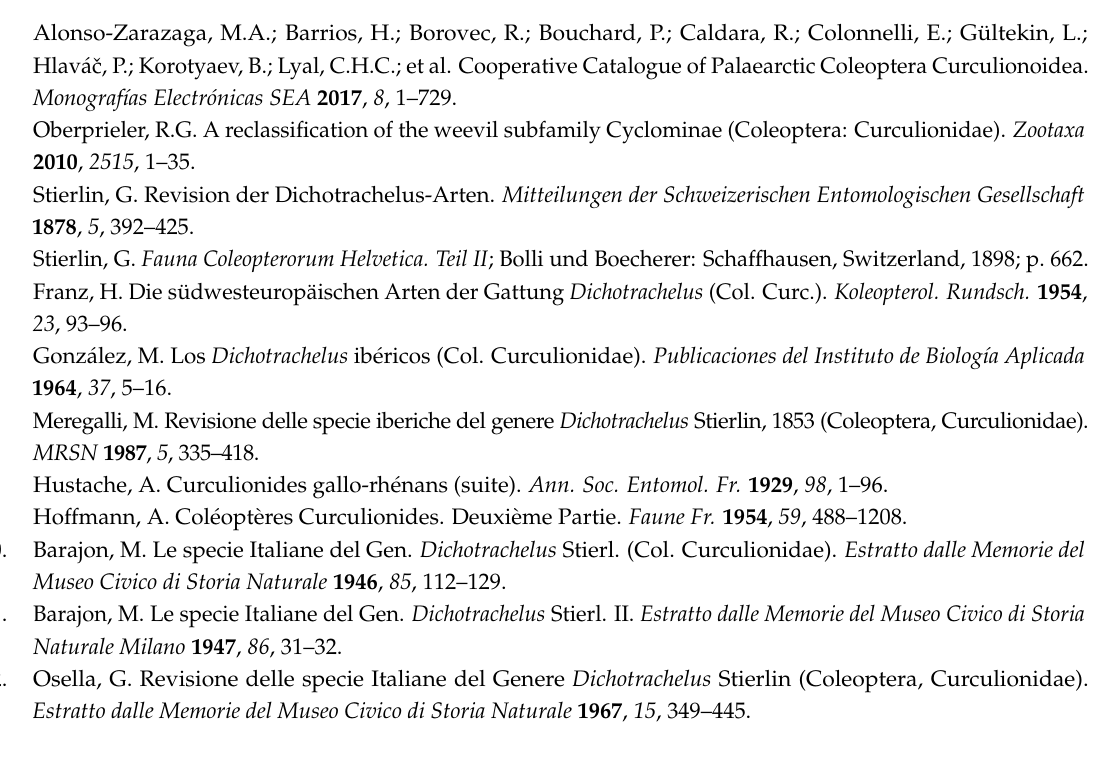
Table I. List of the species and specimens examined. For the mt-Cox1 analysis, specimens sequenced in Turin are indicated with an asterisk; Table II Characters matrix for the morphological analysis; Table III. Pairwise distance of mt-Cox1 , bases. The number of base differences per site from between sequences are shown. There were a total of 774 positions in the final dataset; Table IV. Pairwise distance of mt-Cox1 , amino acids. The number of amino acid substitutions per site from between sequences is shown. Analyses were conducted using the Poisson correction model. The rate variation among sites was modelled with a gamma distribution (shape parameter = 1). The coding data was translated assuming a Invertebrate Mitochondrial genetic code table. There were a total of 258 positions in the final